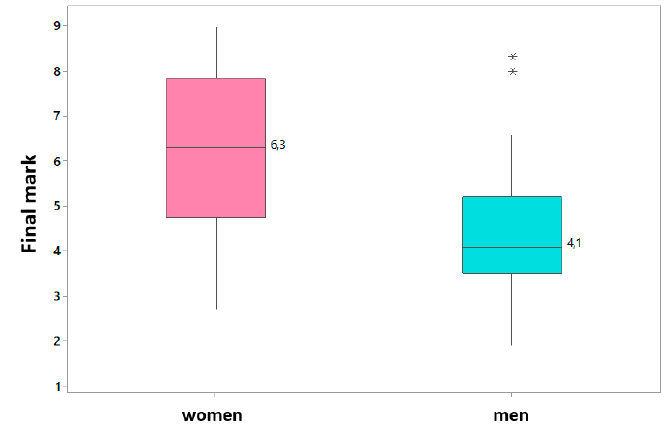
Figure 2. Boxplot of the scores obtained by students in the subject according to their gender.